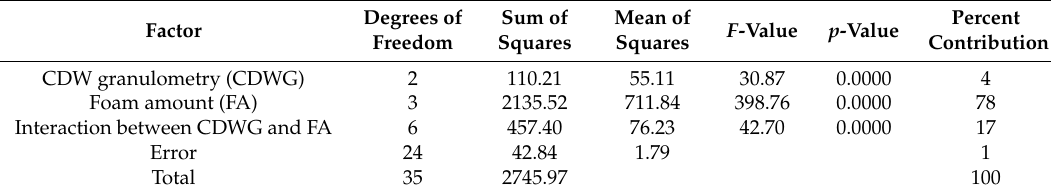
Table 7. ANOVA for air void (AV).